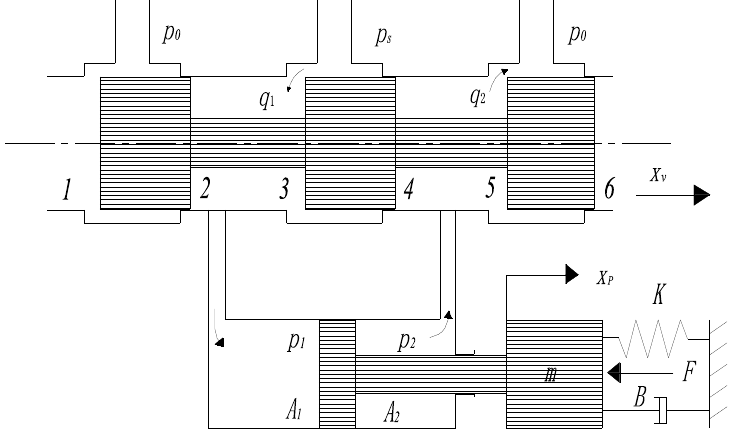
Figure 1. Structure diagram of valve ‐ controlled asymmetric hydraulic cylinder.